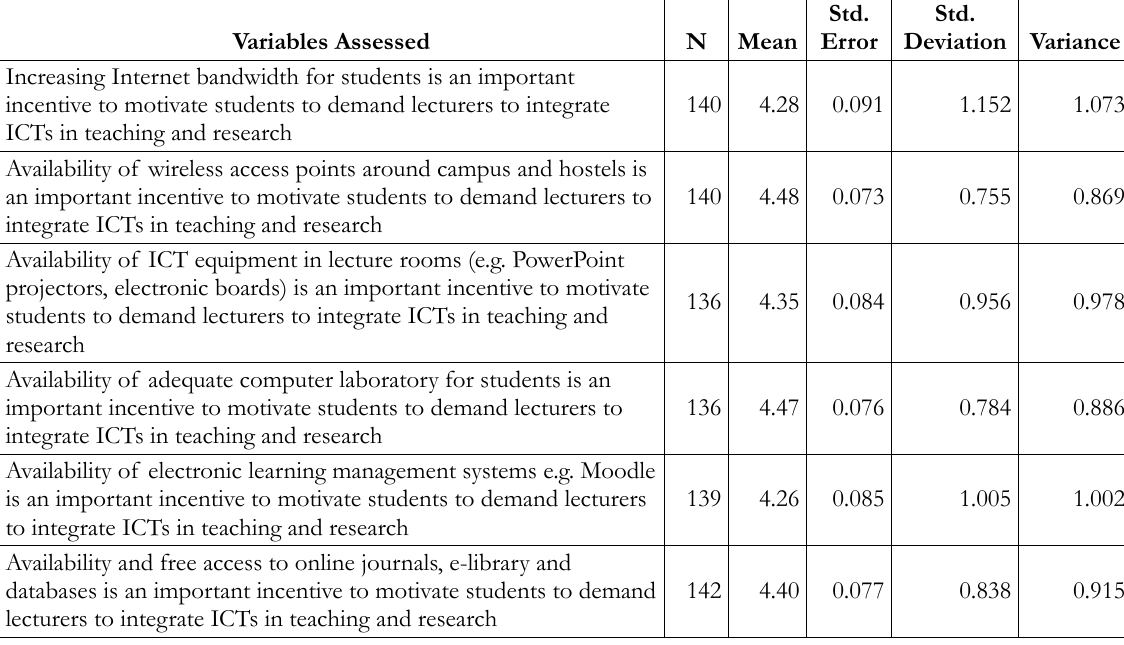
Table 7. Incentives for students to demand for lecturers to integrate ICTs in teaching and